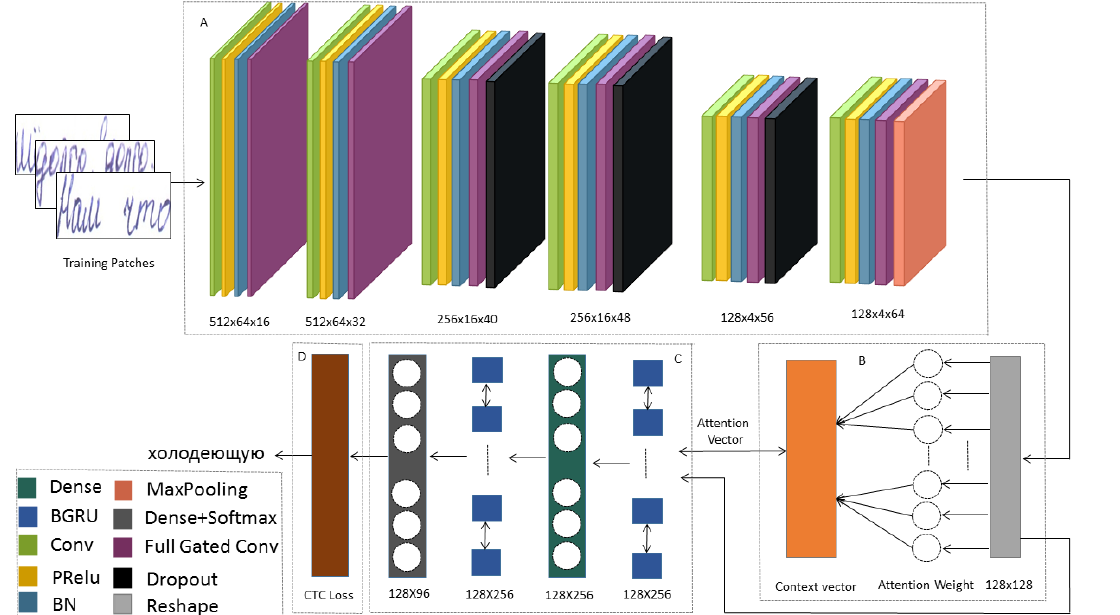
Figure 1. Attention-Gated-CNN-BGRU architecture for handwriting recognition. The system contains four main parts: ( A ) encoder, ( B ) attention block, ( C ) decoder, ( D ) CTC. An input image is